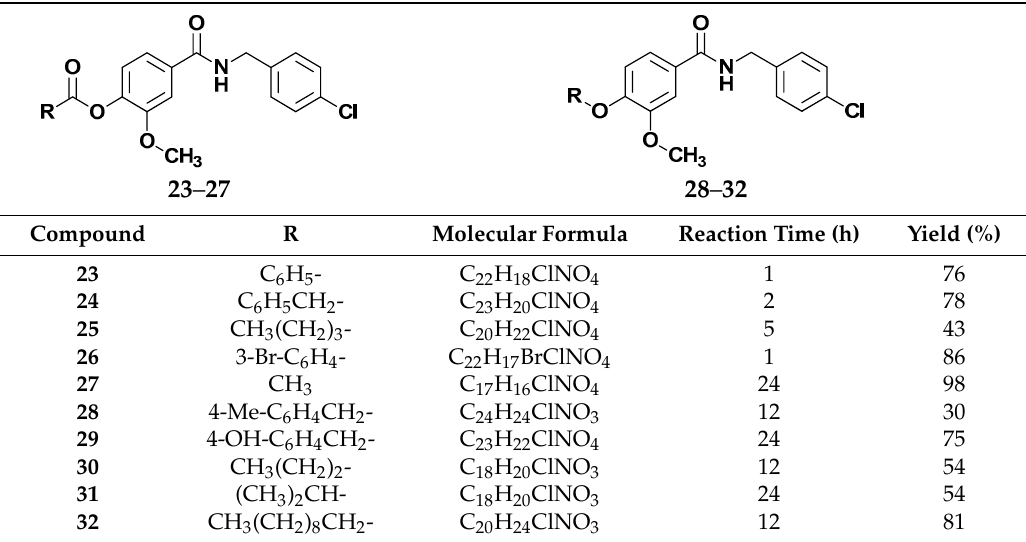
Table 2. Data from amide 15 derived ethers and esters.